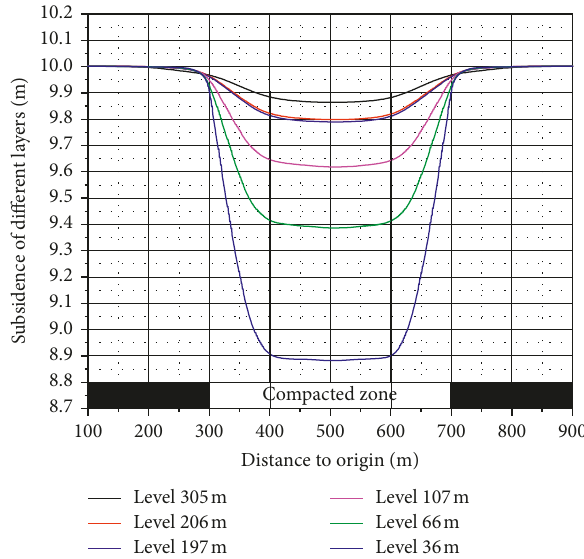
Figure 13: Width of the compacted zone of different levels in the numerical